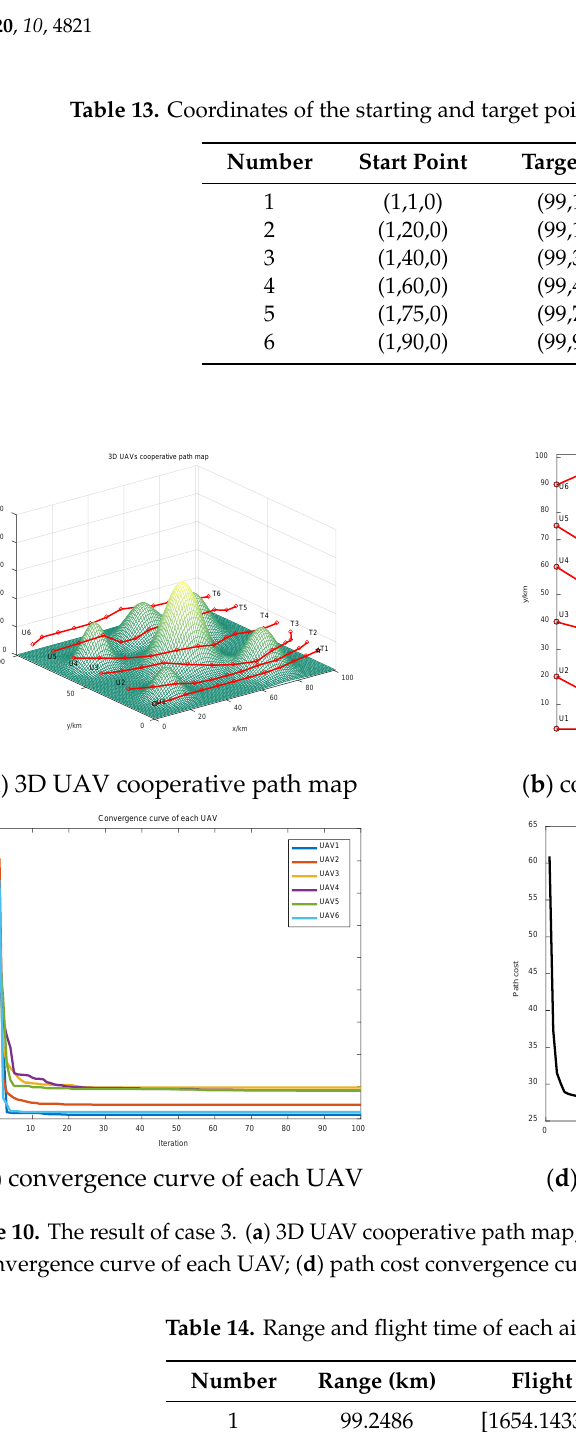
Table 15. Coordinates of the starting and target points of all UAVs (case 4).